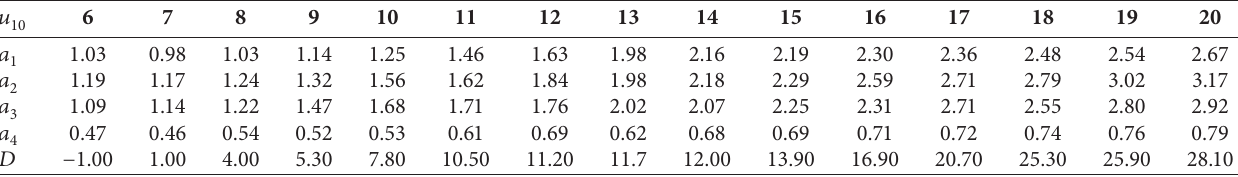
Table 3: Standardized statistical results of characteristic parameters calculated by KA method for freak waves at different wind speeds.